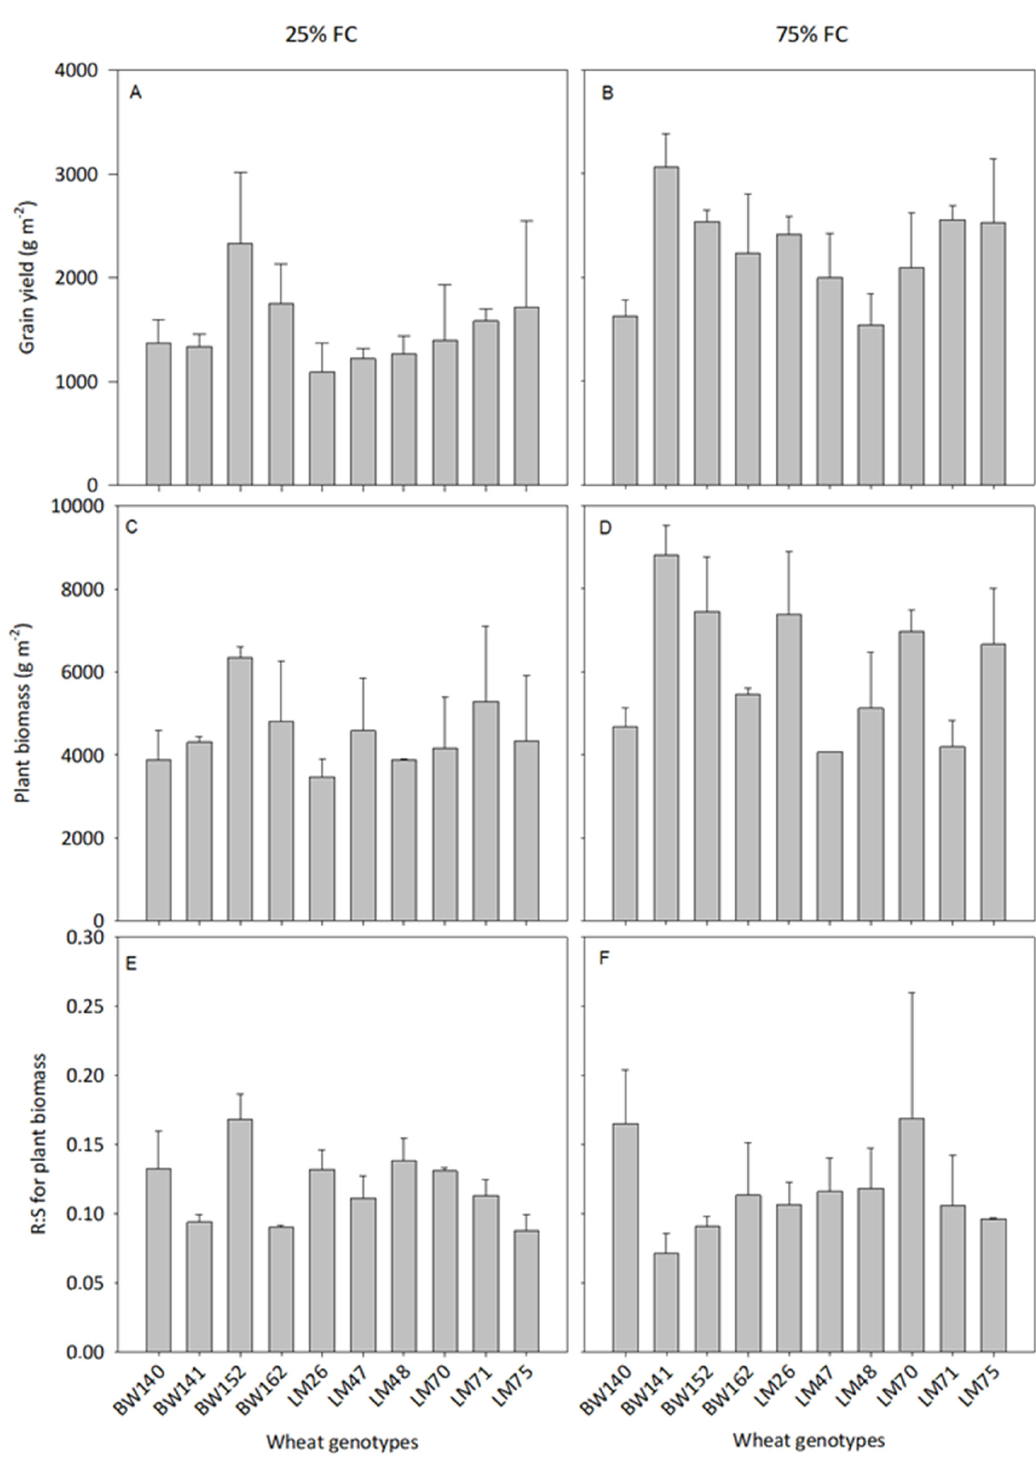
(Figure 5). Under 75% FC, BW140 ranked first for PCs (2733 g C m − 2 ), followed by BW162 (2259 g C m − 2 ), LM70 (2277 g C m − 2 ) and LM75 (2072 g C m − 2 ), while all the other cultivars had significantly lower PCs.